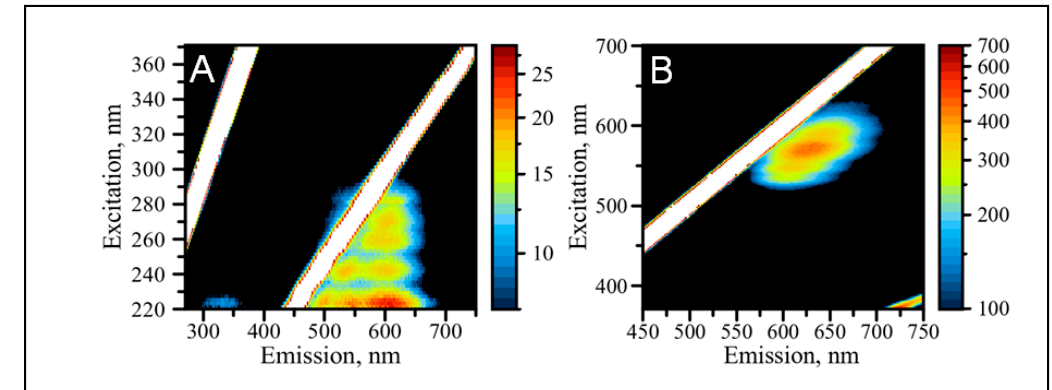
Figure 2. Detailed excitation-emission maps of AgNC/C 12 -loop-miR21-probe. ( A ) UV/UV-Vis excitation-emission map and ( B ) Vis/Vis excitation-emission map.